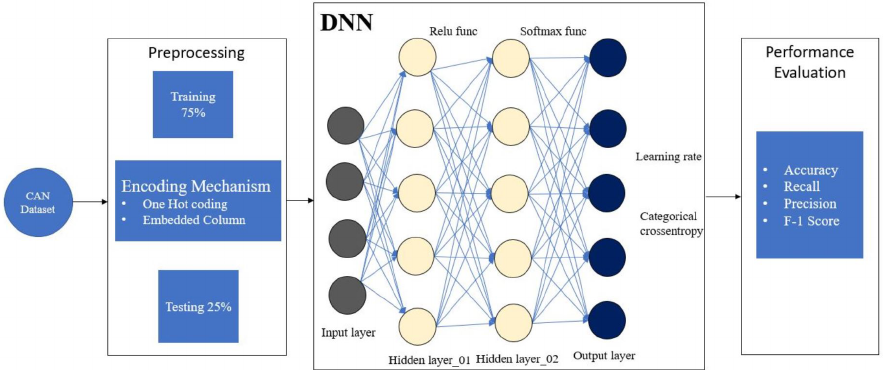
Figure 9. Structure of the proposed DNN